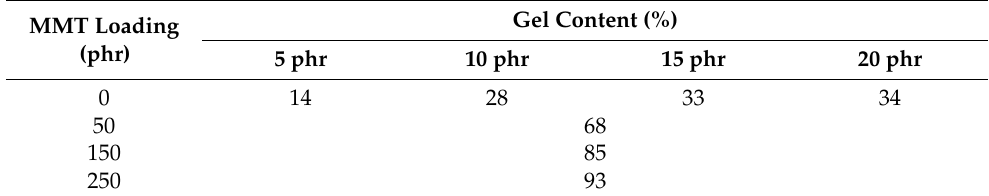
Table 3. Modification of gel fraction in LDPE/EVA nanocomposites for various MMT loadings